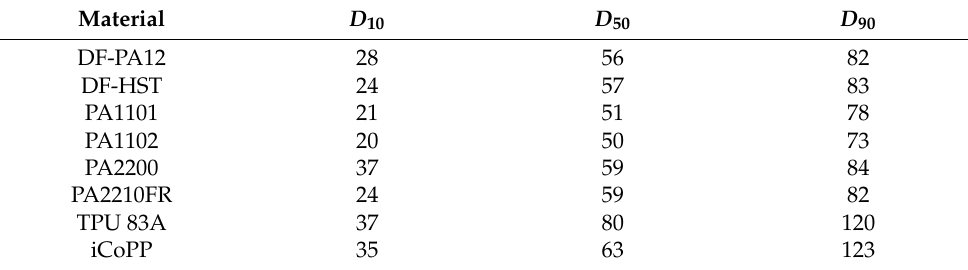
Table 2. Particle size distribution, all values are in µ